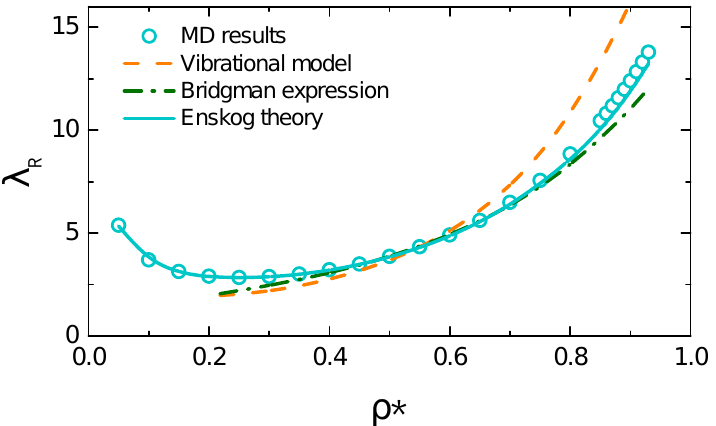
Figure 1. (Color online) Macroscopically reduced thermal conductivity coefficient λ R of the HS fluid as a function of the reduced density ρ ∗ . Symbols correspond to the numerical results from Ref. [48]. The dashed curve denotes the calculation using the vibrational model, the dash-dotted curve corresponds to the Bridgman’s expression, and the solid curve is plotted using the Enskog